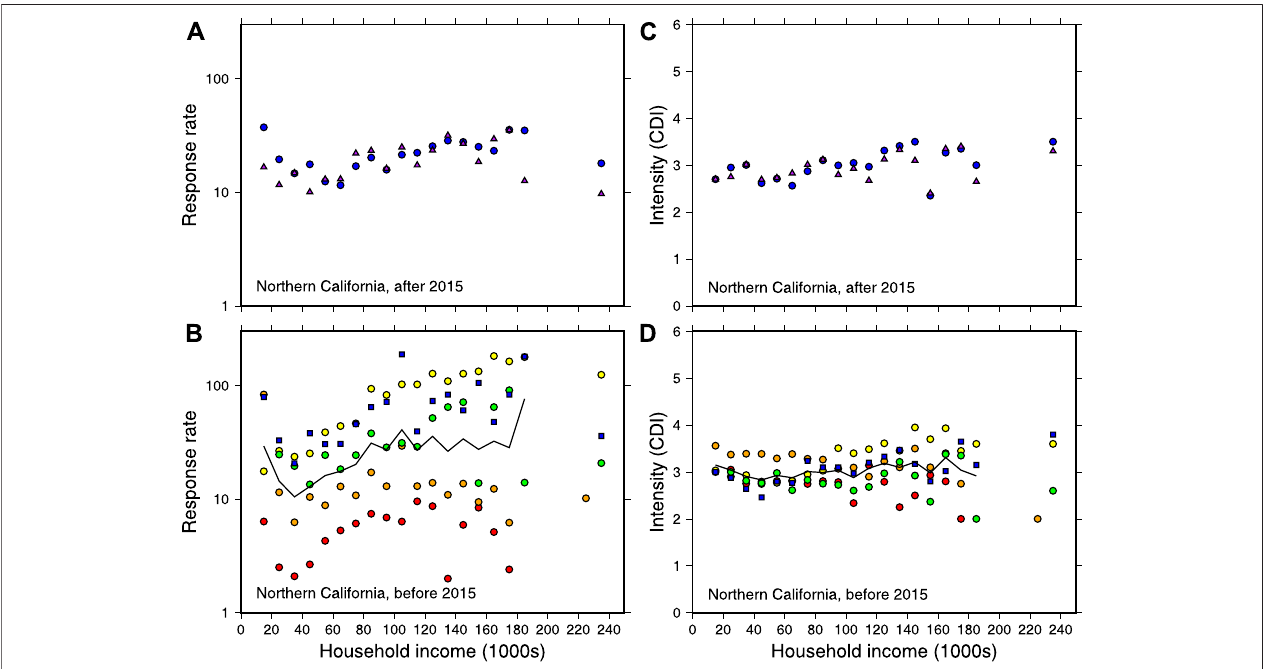
FIGURE 2 | (A, top left) Response rate (scaled by 10,000) in individual ZIP codes versus average household income for earthquakes in northern California after 2015.Coloredsymbolsshowresponseratesforindividualeventsbin-averaged overincomes +/ − $10,000,witheach eventshownwithadifferentsymbol.Averagesnot shown in (A,B) because each dataset includes only two events. (B, top right) Bin-averaged average intensity versus average household income for earthquakes in northern California after 2015. Results for different events are shown with different colored symbols. (C, bottom left) Bin-averaged scaled response rate for earthquakes in northern California before 2015. Symbols for individual events are plotted with different colors. (D, bottom right) Bin-averaged intensity data for earthquakes in northern California before 2015.